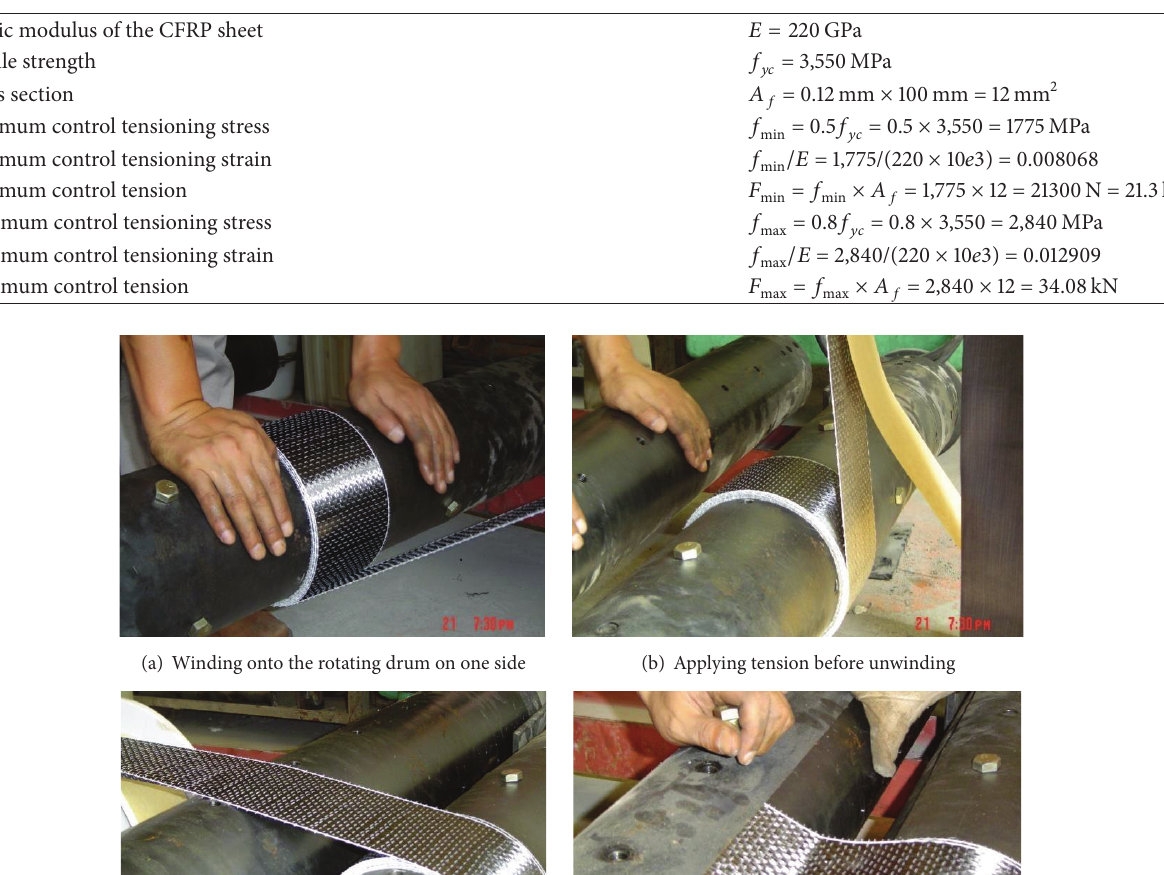
Table 2: List of the control parameters for tensioning.